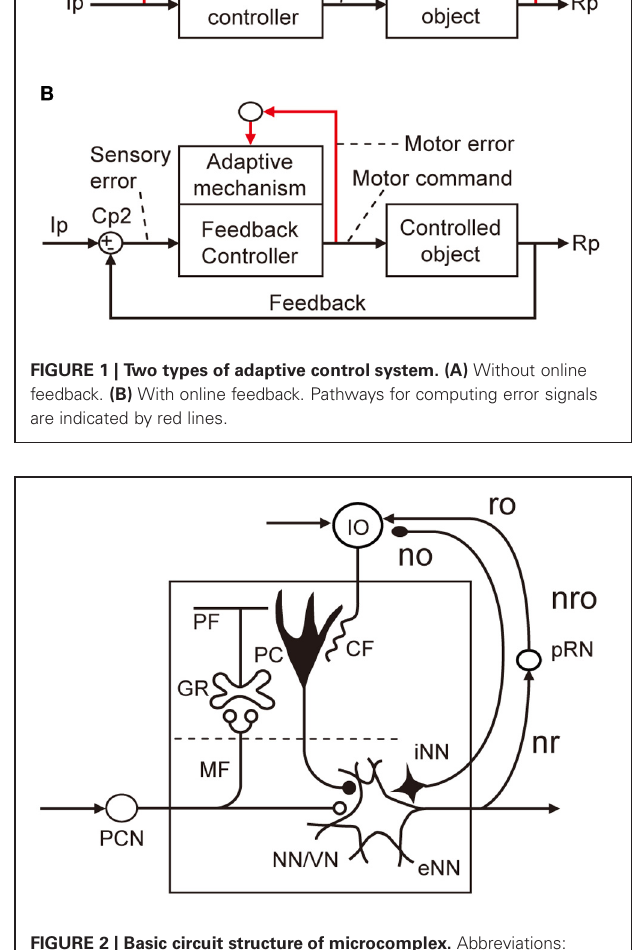
FIGURE 2 | Basic circuit structure of microcomplex. Abbreviations: CF, climbing fiber; GR, granule cell; IO, inferior olive; MF, mossy fiber; NN/VN, nuclear neuron/vestibular nuclear neuron; no, nucleoolivary pathway; nro, nucleorubroolivary pathway; PC, Purkinje cell; PCN, precerebellar neuron; PF, parallel fiber; pRN, parvocellular red nucleus; eNN, excitatory nuclear neuron; iNN, inhibitory nuclear neuron; ro, rubroolivary pathway; nr, nucleorubral pathway Inhibitory neurons are in black (others are